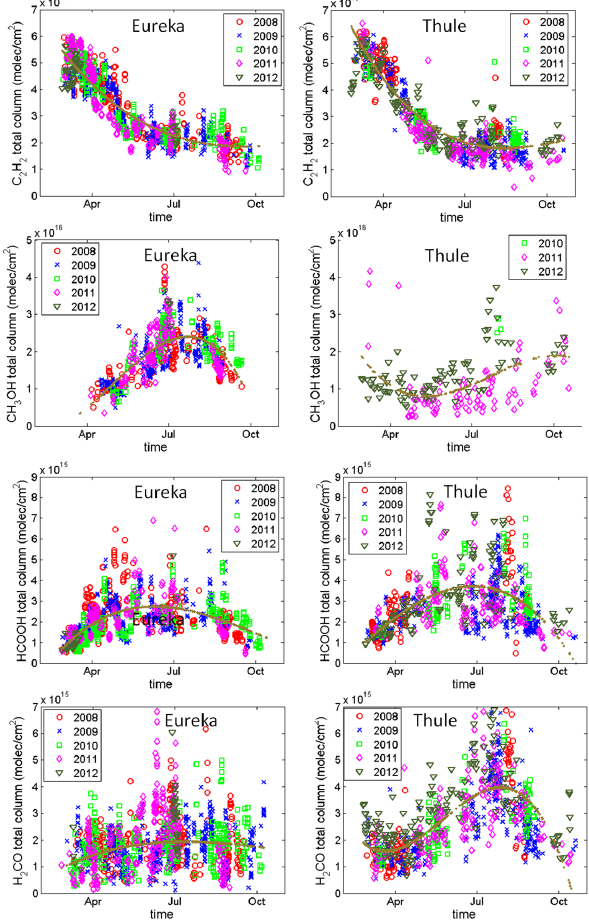
Figure 3. Time series of C 2 H 2 , CH 3 OH, HCOOH and H 2 CO total columns measured at Eureka (left panels) and Thule (right panels) from 2008 to 2012. The brown lines represent the polynomial fits to the